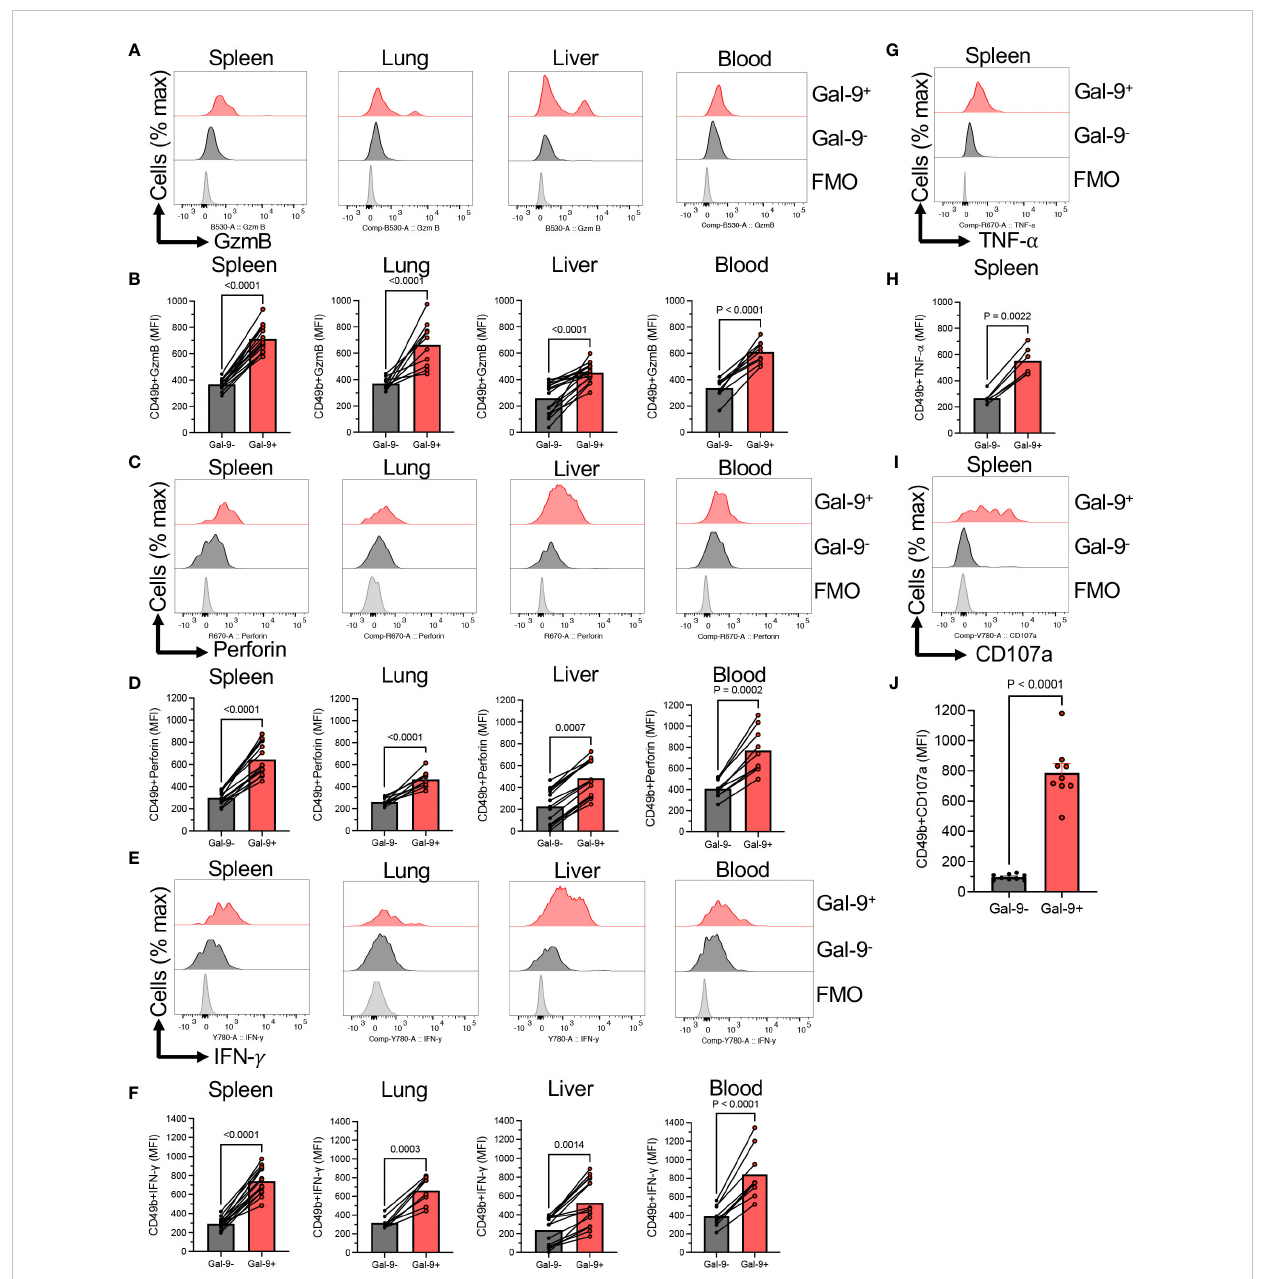
FIGURE 2 Gal-9 + NK cells display an activated phenotype compared to their negative counterparts. (A) Representative histogram plots, and (B) cumulative data showing the intensity of granzyme-B (GzmB) expression as measured by the mean fl uorescence intensity (MFI) in Gal-9 + and Gal-9 - NK cells from the spleen, lung, liver and blood of adult BALB/c mice. (C) Representative histogram plots, and (D) cumulative data showing the intensity of perforin expression as measured by the MFI in Gal-9 + and Gal-9 - NK cells from the spleen, lung, liver and blood of adult BALB/c mice. (E) Representative histogram plots, and (F) cumulative data showing the intensity of IFN- g expression as measured by the MFI in Gal-9 + and Gal-9 - NK cells from the spleen, lung, liver and blood of adult BALB/c mice. (G) Representative histogram plots, and (H) cumulative data showing the intensity of TNF- a expression as measured by the MFI in Gal-9 + and Gal-9 - NK cells from the spleen of adult BALB/c mice. (I) Representative histogram plots, and (J) cumulative data showing the intensity of CD107a expression as measured by the MFI in Gal-9 + and Gal-9 - NK cells from the spleen of adult BALB/ c mice. Each dot represents data from an animal, mean ± SEM from multiple independent experiments. Fluorescence minus one